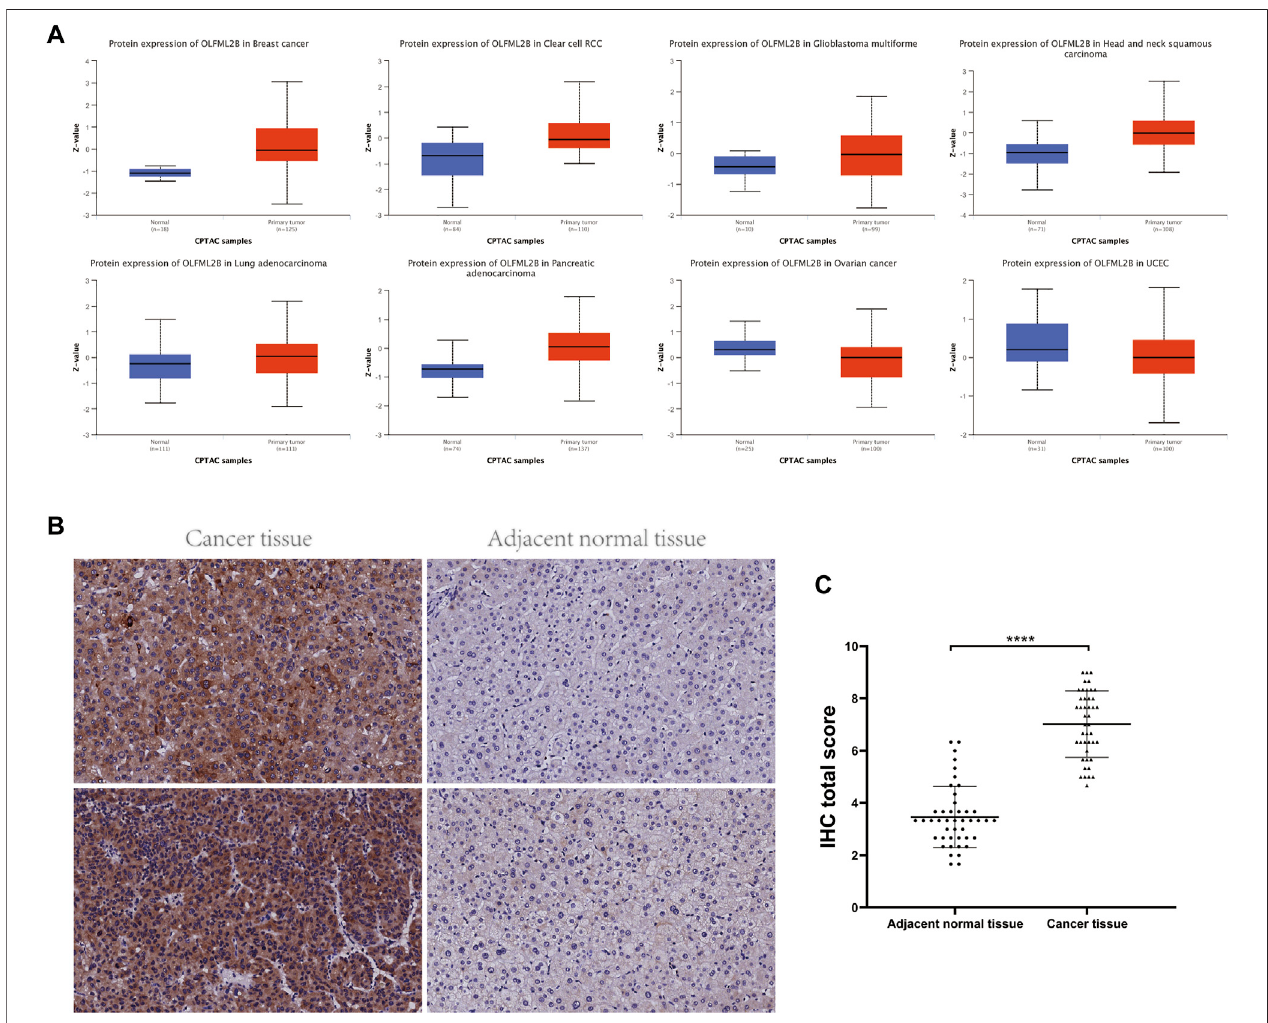
FIGURE 2 | Protein expression level and prognostic value of OLFML2B. (A) Protein expression level of OLFML2B in the UALCAN database. (B) Higher OLFML2B expression and lower OLFML2B expression in the human liver cancer tissues and adjacent normal tissues. (C) H-score of OLFML2B IHC staining of cancer tissues and corresponding adjacent normal